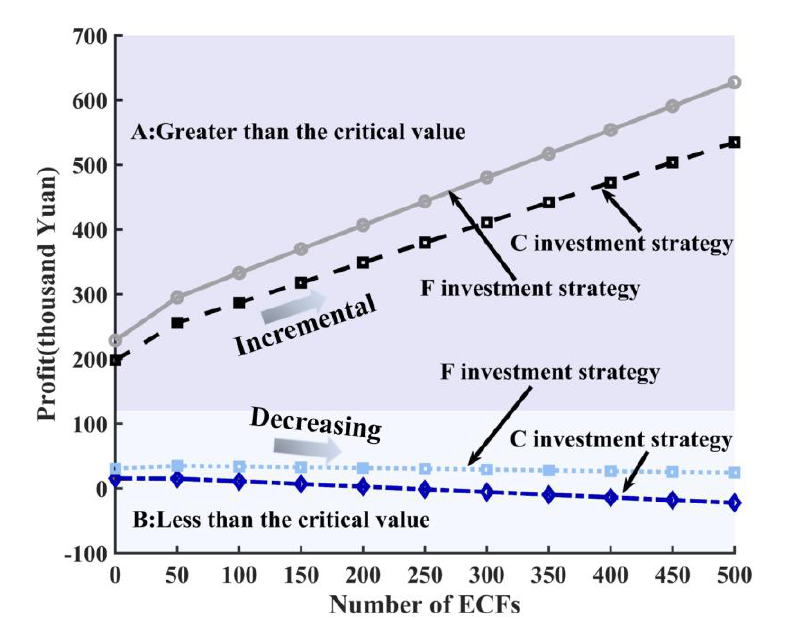
Figure 8. ECF-investment profit changes with the number of